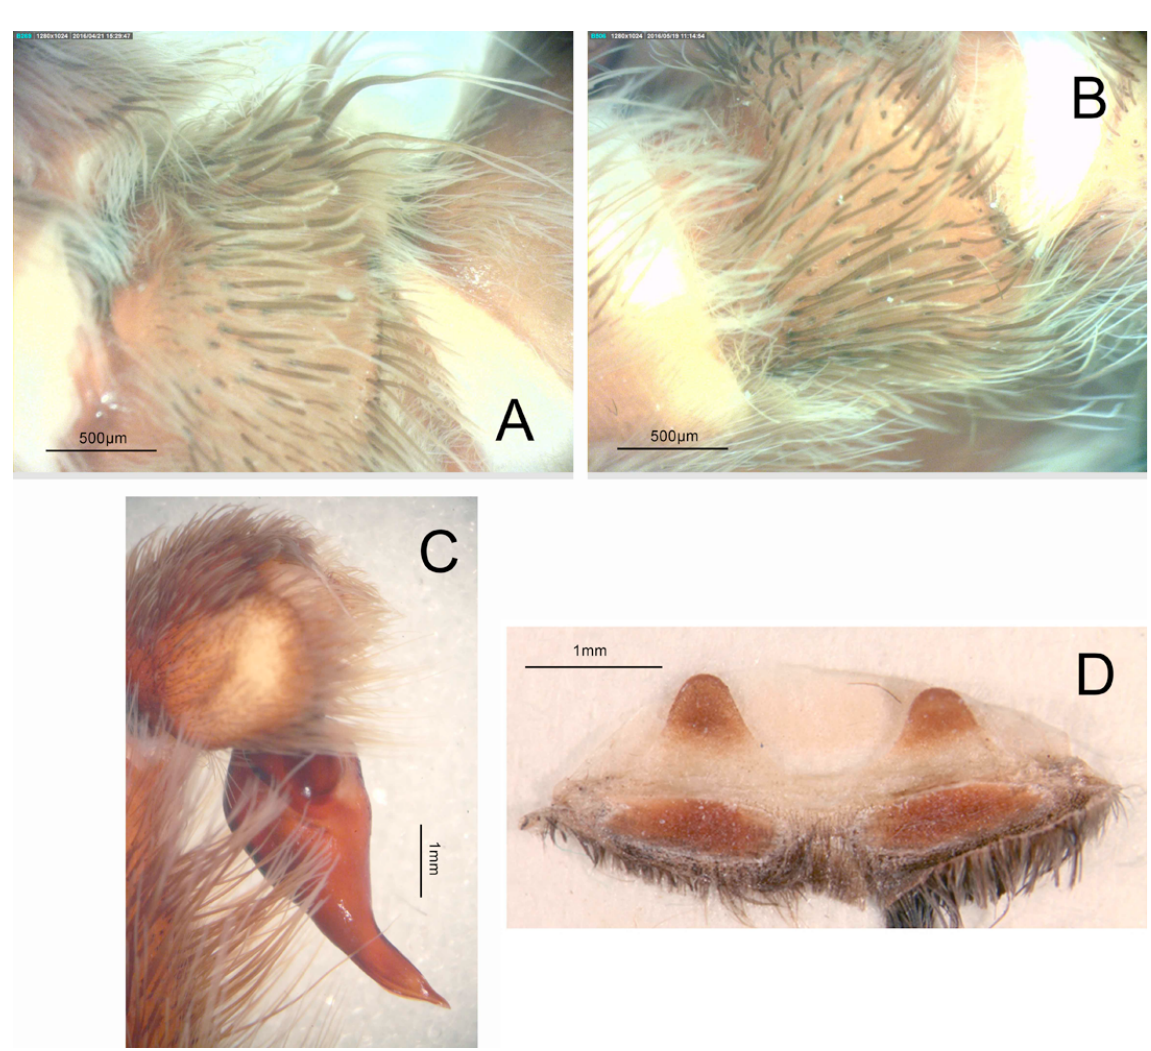
Fig. 4. Nesipelma insulare Schmidt & Kovarik, 1996 , ♂ (SMF 38557-84) and ♀ (SMF 39188-84) from the Lesser Antilles, Nevi Island. A–C . Male palp. A . Trochanter, stridulatory organ. B . Trochanter I, stridulatory organ. C . Retrolateral. D . Spermathecae, female, dorsal (Photos by P. Jäger and C.